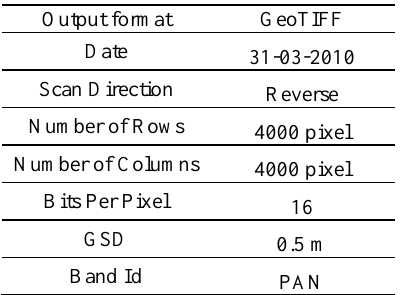
Table 1. Details of images used to generate DSM.